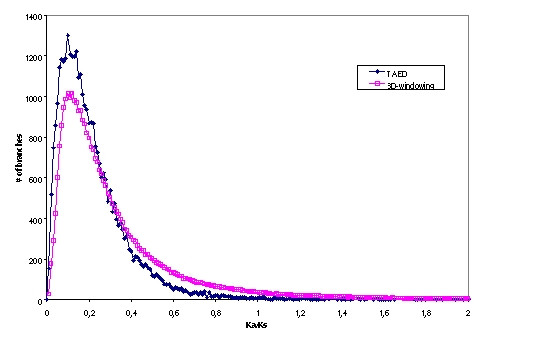
The distribution of Ka/Ks values calculated from TAED using a 3D windowing (structurally- delineated) approach is shown overlaid on the whole gene averaged dataset from Figure 1. An equal number of branches is represented for each dataset. An excess of positive (and negative) selection is detected in the 3D windowing approach compared with the whole gene averaged approach (see the main text for an expanded discussion of this).